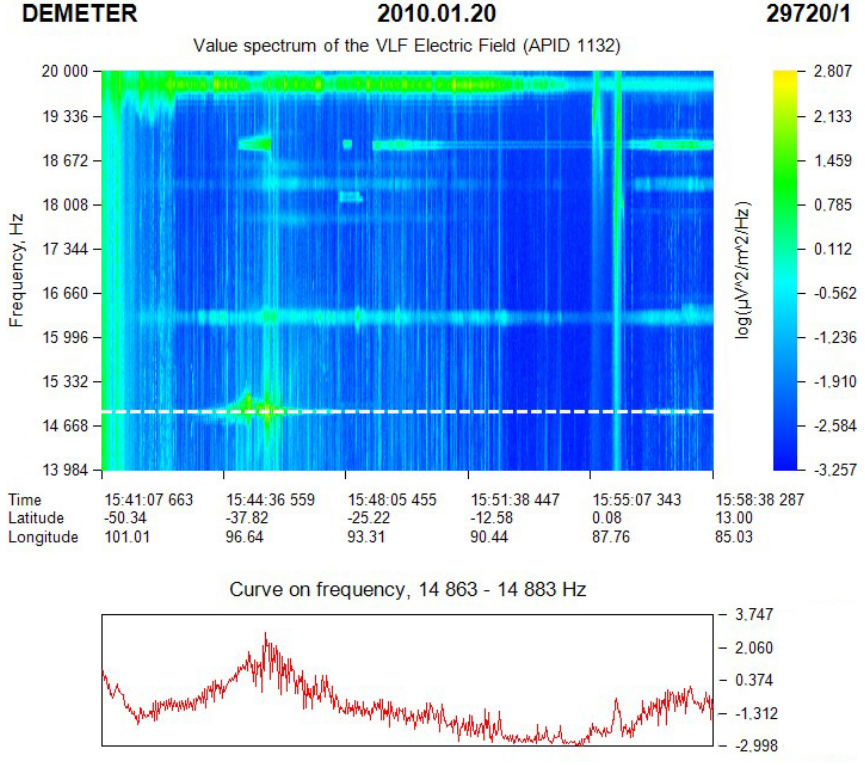
Figure 2. Spectrum of the electric component of the electromagnetic field and amplitude (bottom graph) at the operational frequency 14881Hz (dashed line) of the VLF transmitters of the Alpha (RSDN-20) radio